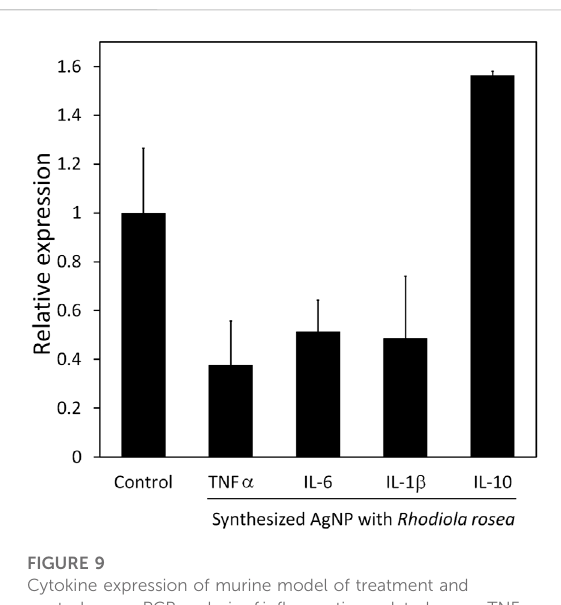
FIGURE 9 Cytokine expression of murine model of treatment and controlgroup.PCRanalysisofin fl ammation-relatedgenes,TNF- α , IL-6, IL-1 β , and IL-10. Expression levels were normalized to GAPDH. Data are presented as mean SEM. Three independent experiments were carried